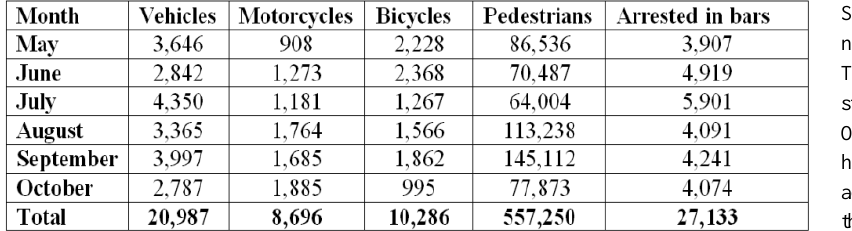
Statistics indicate that many people do not adhere to preventive measures. Table 1 (RNP statistics, 2020) presents statistics of violators from May